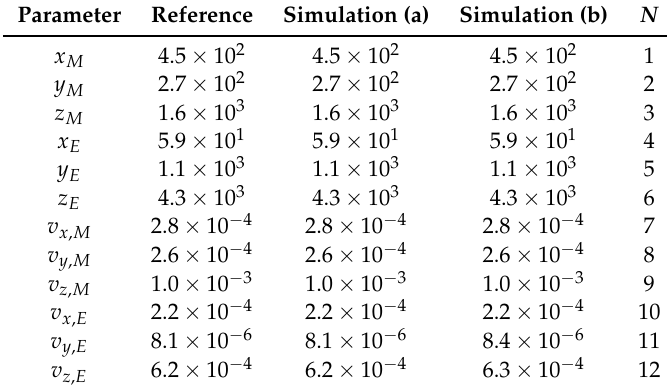
Table 3. Formal accuracies expected for the state vectors (position and velocity in cartesian coordinates) of Mercury (index M ) and the Earth–Moon barycenter (EMB) (index E ) in the case of: reference simulation, simulation (a) and simulation (b), respectively. In the last column, we introduce a reference number, N , which labels each parameter, that will be adopted in Section 4.3. The results are expressed in cm and